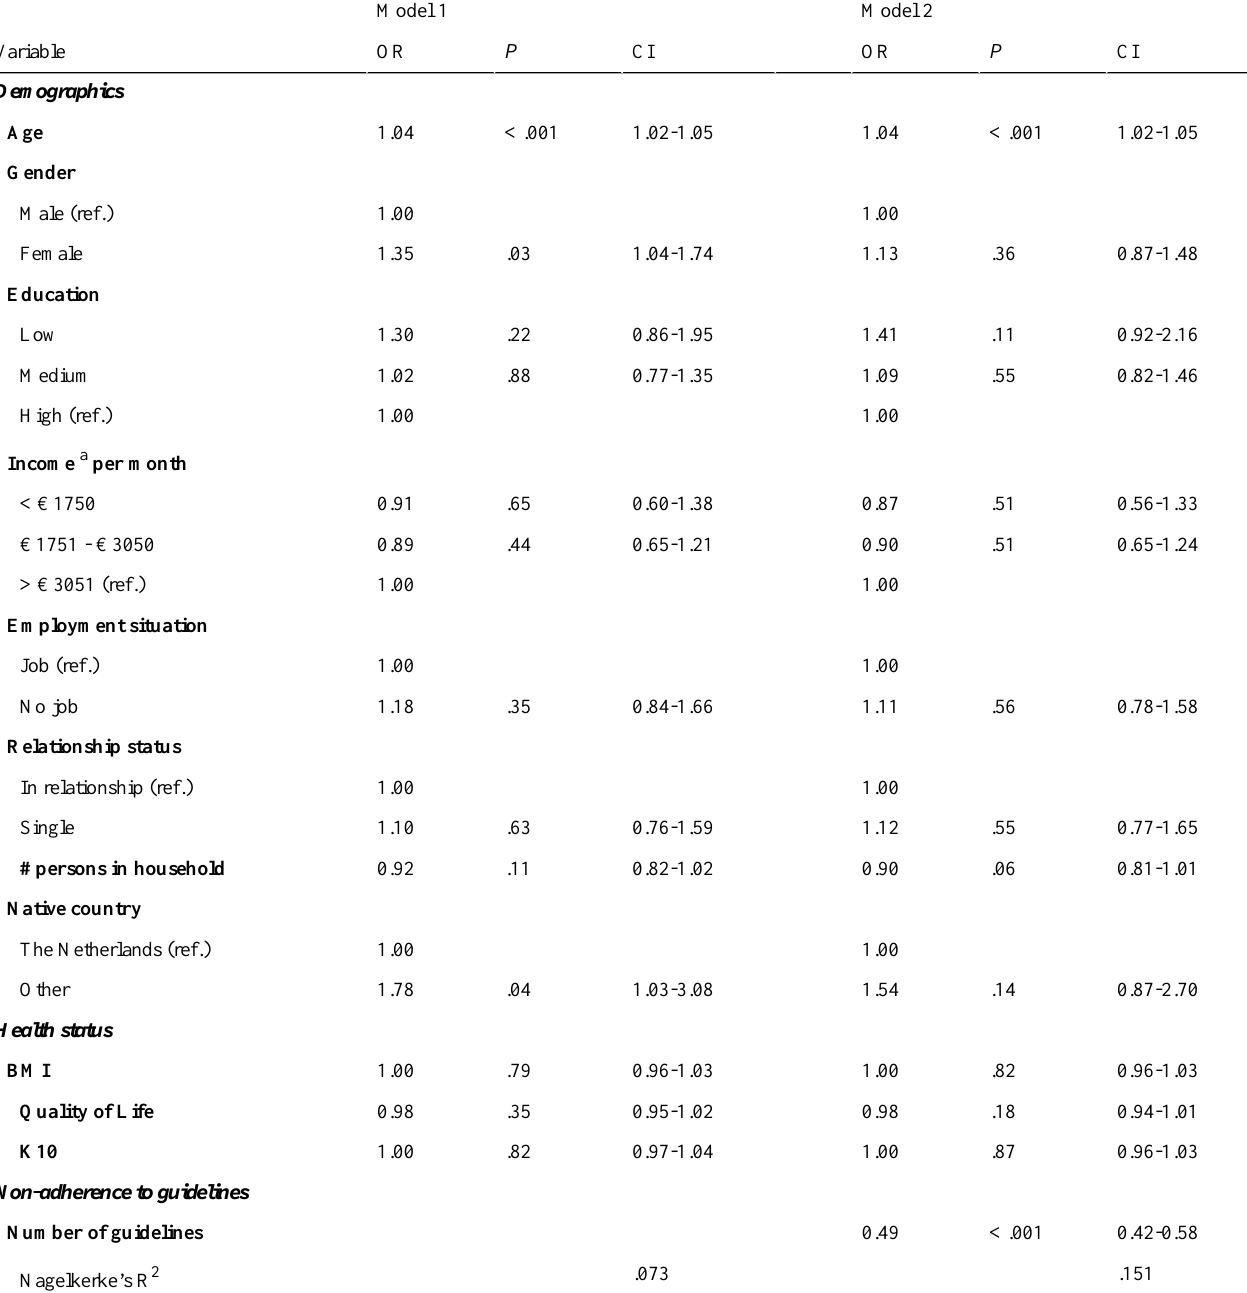
Table 4. Results of logistic regression analyses (Enter method) among the simultaneous condition on demographics and health status (model 1) and number of guidelines respondents failed to adhere to (model 2), with completion status (non-completers = 0; completers = 1) as dependent variable